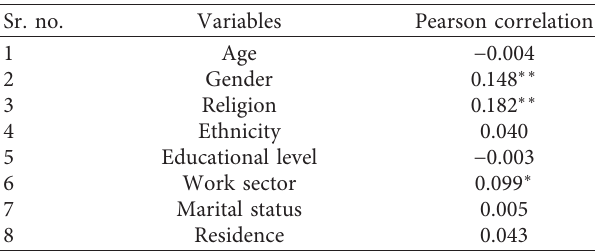
Table 6: Correlation between food safety practice and selected